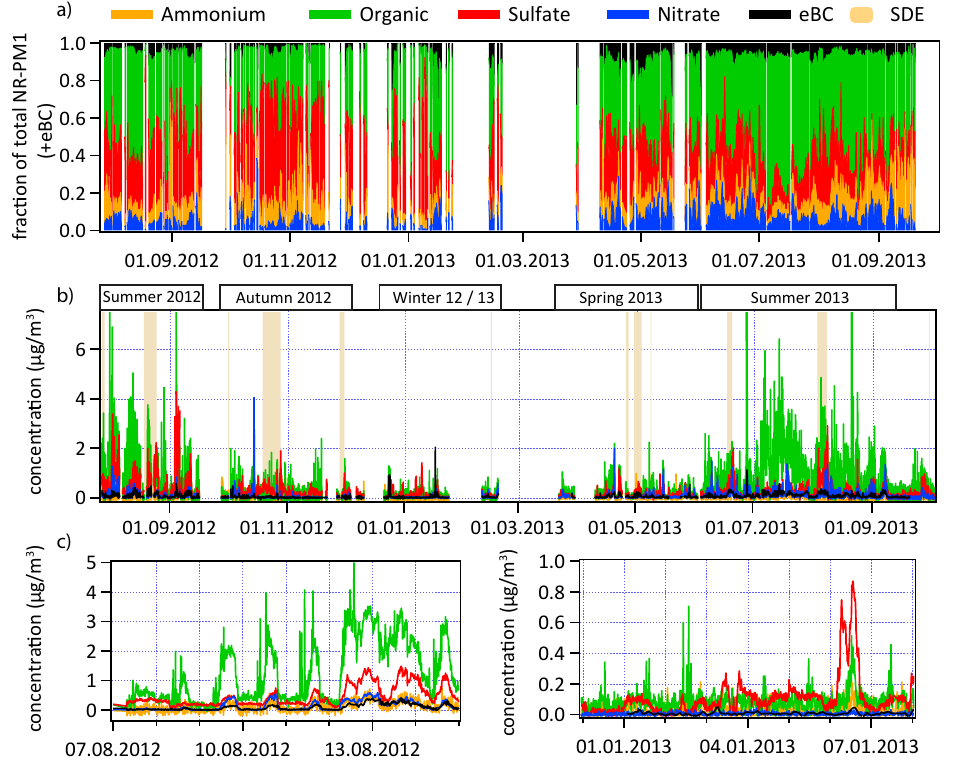
Figure 1. (a) Time series of relative organic (green), sulfate (red), nitrate (blue), and ammonium (orange) contributions to the total PM 1 aerosol measured by the ToF-ACSM and the eBC (black) concentration time series measured by the aethalometer from 27 July 2012 to 02 October 2013. (b) Same as (a) in absolute concentrations (µgm − 3 ). Saharan dust events (SDE) are highlighted in light brown. On top of (b) the periods used in the following seasonal analyses are identified. Gaps between seasons are caused by gaps in the data. (c) Left: mass concentrations in µgm − 3 during a typical summer period (7 August 2012 00:00 to 15 August 2012 00:00); right: mass concentrations in µgm − 3 during a typical winter period (01 January 2013, 00:00 to 08 January 2013, 00:00). Note the different y scales of the two plots in (c) . Times are given in